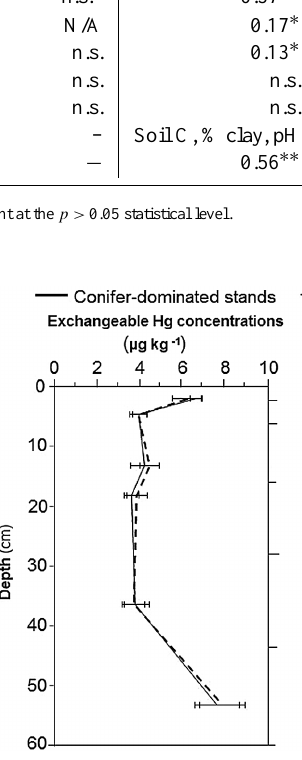
Figure 3. Exchangeable Hg concentrations and % exchangeable Hg in organic and mineral horizons at conifer and deciduous-dominated forest stands. Mean values are given ± 1 standard error. ( ∗ ) indicates a significant difference using two-sample t tests ( P